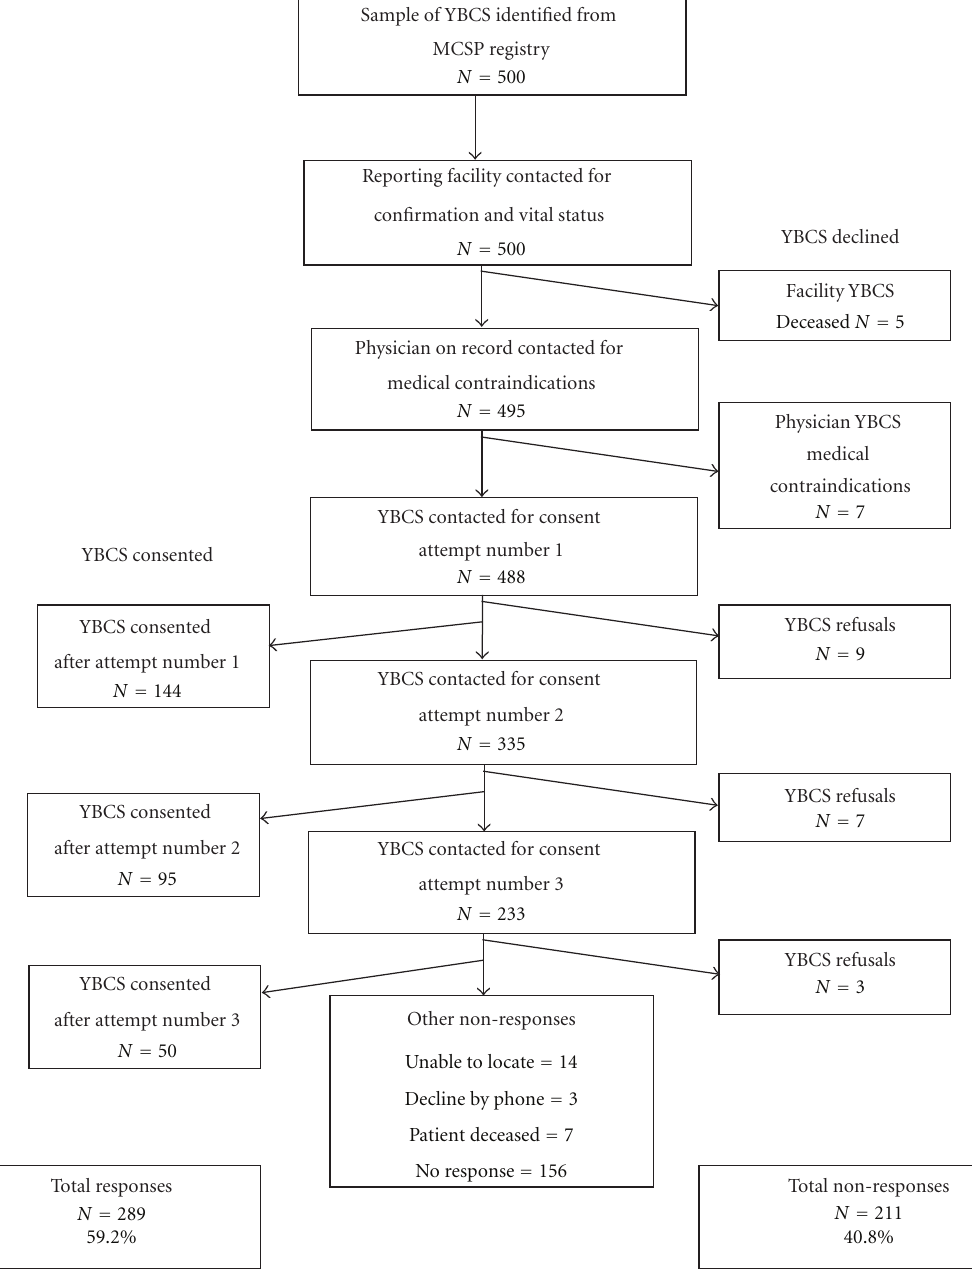
Figure 1: Flow chart of the selection and consent